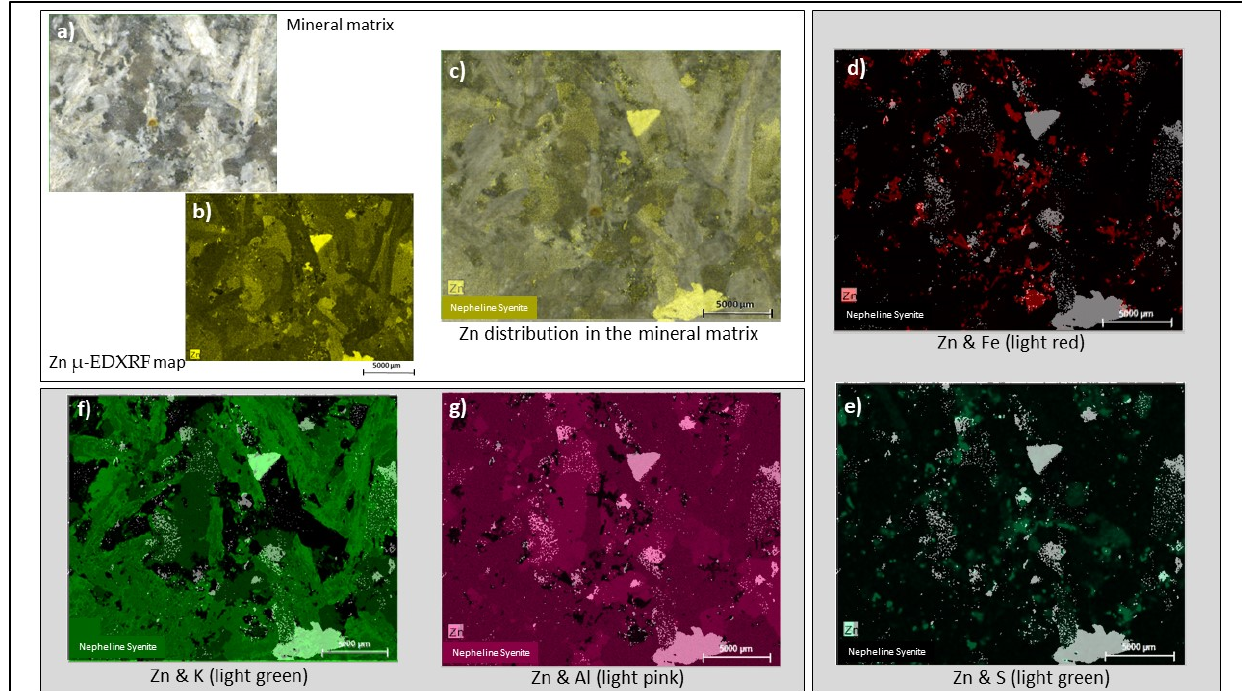
Figure 6. ( a ) Image of original mineral sample (mineral matrix), ( b ) Zn μ‐ EDXRF map, ( c ) Zn distribution in the mineral matrix (overlap of images ( a , b )). Zn distribution and its correlations with ( d ) Fe, ( e ) S, ( f ) K, and ( g ) Al.